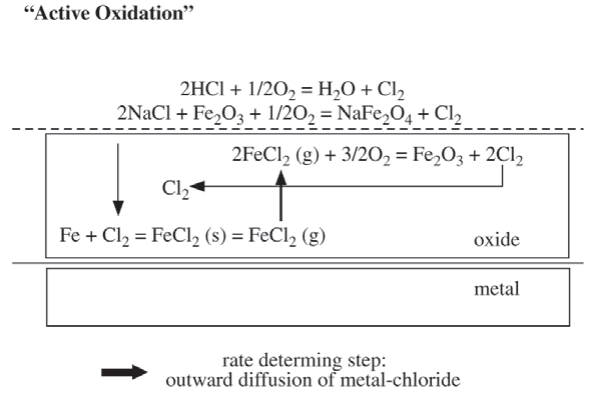
Figure 1. Schematics of the reaction circuit in active oxidation of iron and